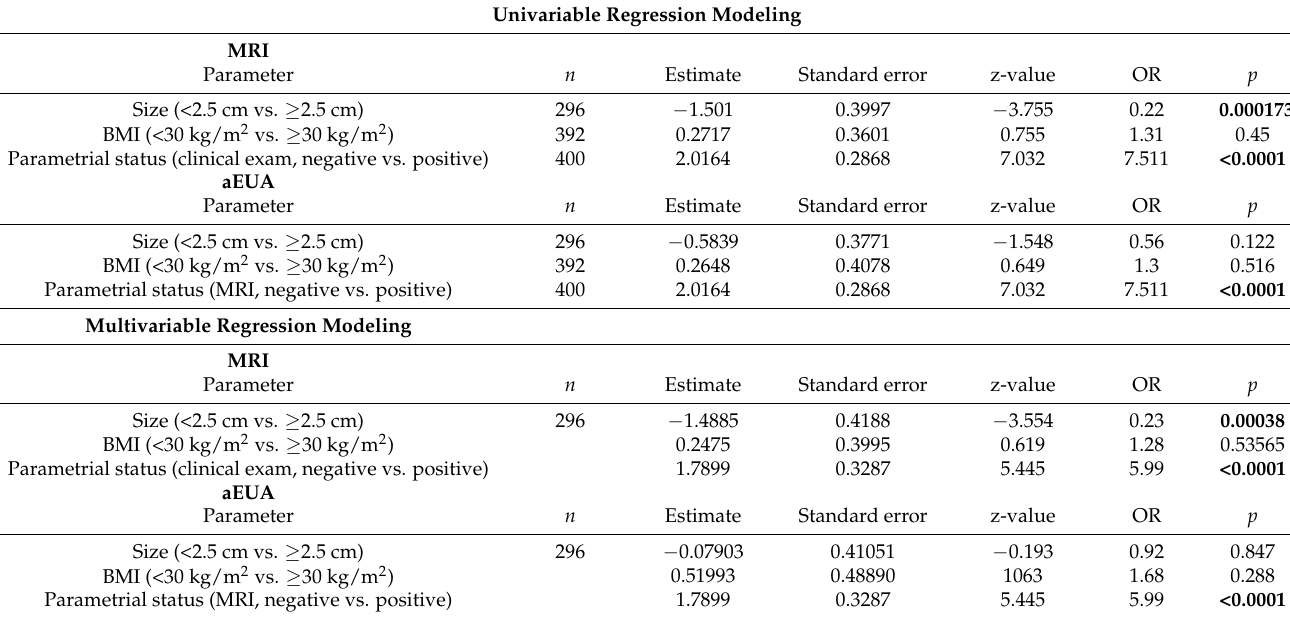
Table 5. Factors influencing accuracy of parametrial assessment by MRI and aEUA: regression